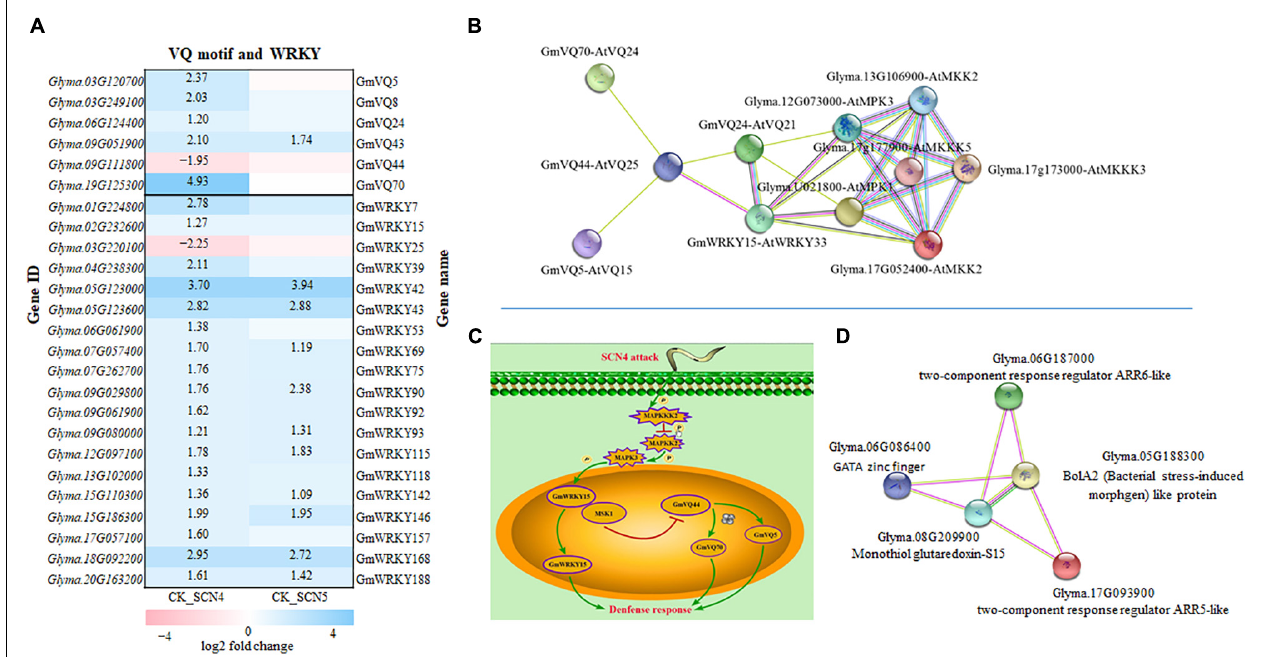
FIGURE 8 | Gene expression of VQ (valine-glutamine motif) and transcription factor WRKY in soybean infected with soybean cyst nematode race 4 (SCN4) and SCN5 when compared with the control (CK), and protein-protein interactions. (A) All differentially expressed VQ and WRKY genes are displayed; white blank block (0) means no expression variations detected with Fold Change ≥ 2 and False Discovery Rate (FDR) < 0.05; the left side of the y -axis is gene ID and the right side is the corresponding gene name (Yu et al., 2016; Wang et al., 2019). (B) VQ-WRKY-MPK-MKK-MKKK interactions (MPK, mitogen-activated protein kinases). (C) Schematic model for VQ-WRKY interaction roles in defense response; SCN4 infection could regulate enzyme activities of MKKK, MKK, and MPK. One model is that MPK activation is able to release WRKY from the substrate MSK1 (GmVQ24) and function for plant defense; the other model is that the released MSK1 binding with GmVQ44 suppress GmVQ44 expression, which may activate GmVQ5 and GmVQ70, and consequently GmVQ5/70 plays a role in plant defense. (D) ARR-BolA2-GRXS15 interactions; ARR-A, type A Arabidopsis response regulator; BolA2, (bacterial stress-induced morphogen)-like protein;GRXS15, monothiol glutaredoxin-S15. The lines in varied colors represent the type of interaction evidence